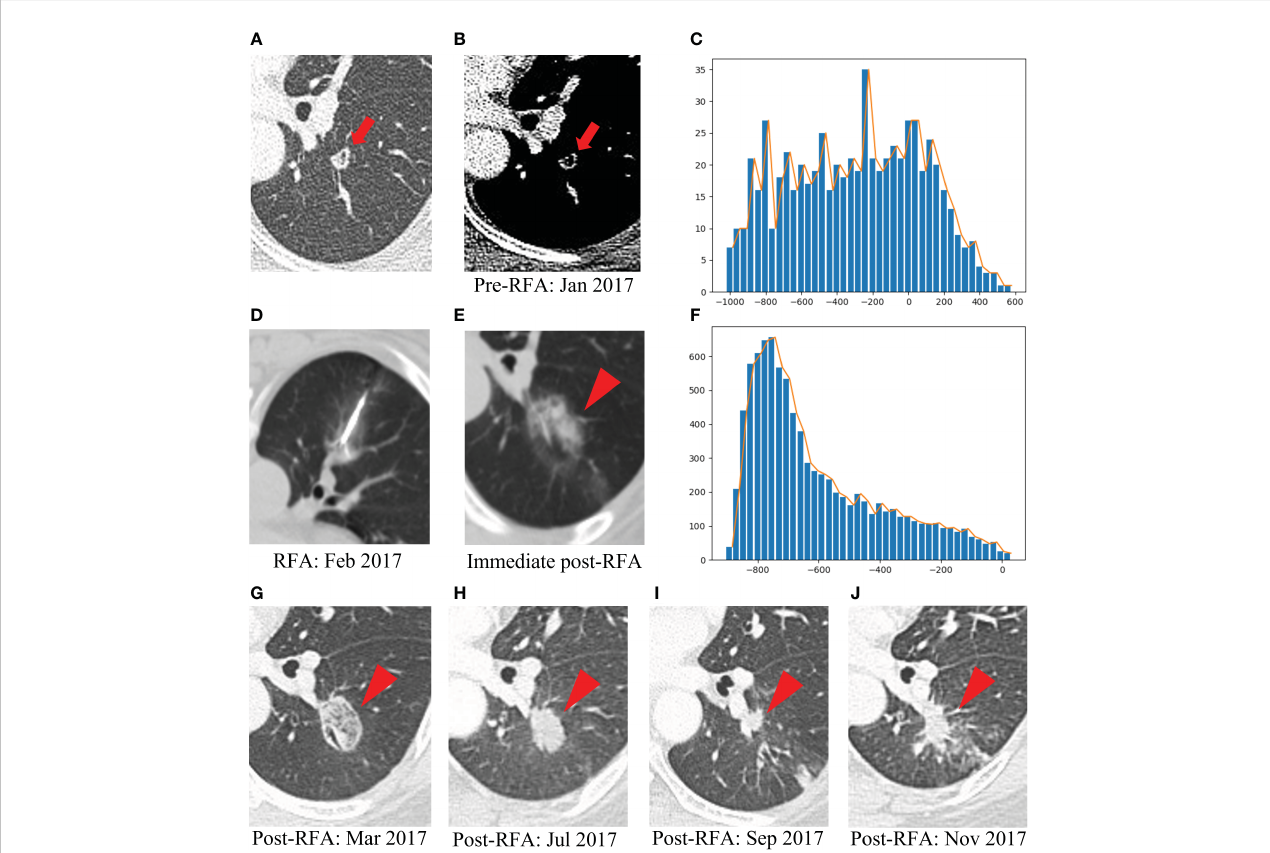
FIGURE 7 Example of a patient with post-lung RFA non-CR. The multimodal data fusion model predicted the results: CR: 0.06, Non-CR: 0.94. (A) A 52-year-old female pT4N1M1R0 rectal cancer patient with a lung metastasis eight months after rection, which was located in the left lower lobe (red arrow). (B) The mediastinal window of enhanced CT showed that the lesion was accompanied by small cavities with a maximum diameter of 9 mm (red arrow). (C) The histogram of the densities within this nodule on the pre-RFA CT scans was fl at, without peak among the high tissular attenuations (x-axis: attenuation in Houns fi eld units, y- axis: number of voxels). (D) The RFA was performed under CT guidance. (E) GGO occurred after RFA (red arrowhead). (F) The histogram of the densities within the ablation zone on the immediate post-RFA CT scans displayed an asymmetric, skewed distribution (x-axis: attenuation in Houns fi eld units, y-axis: number of voxels). (G) Chest CT scan showed high density GGO with clear boundary one month after RFA (red arrowhead). (H) Five months after RFA, the GGO became a high-density nodule (red arrowhead). (I) Seven months after RFA, the high-density nodule shrank, but there was an irregular nodule near the vessel in the ablation area (red arrowhead). (J) Nine months after RFA, the irregular nodule was progressively enlarged and the recurrence was considered (red arrowhead). RFA, radiofrequency ablation; CR, complete response; GGO, ground glass